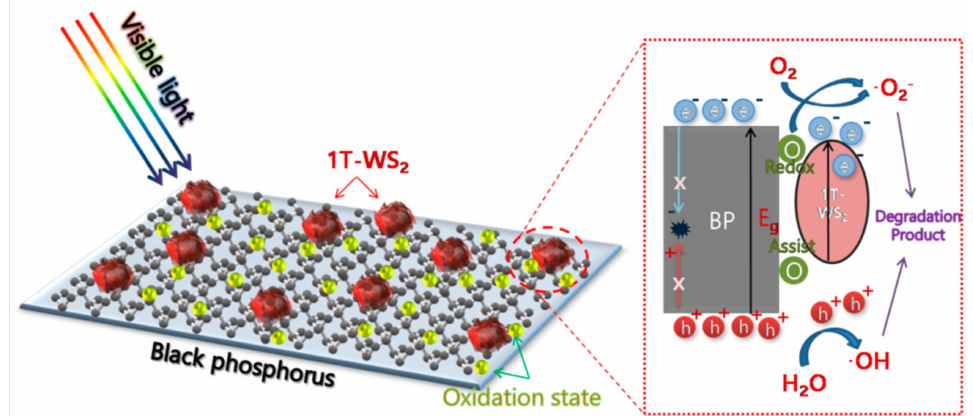
Scheme 1. The proposed schematic diagram for the visible light activated photocatalytic mechanism of OBP/1T-WS 2 nanocomposites.